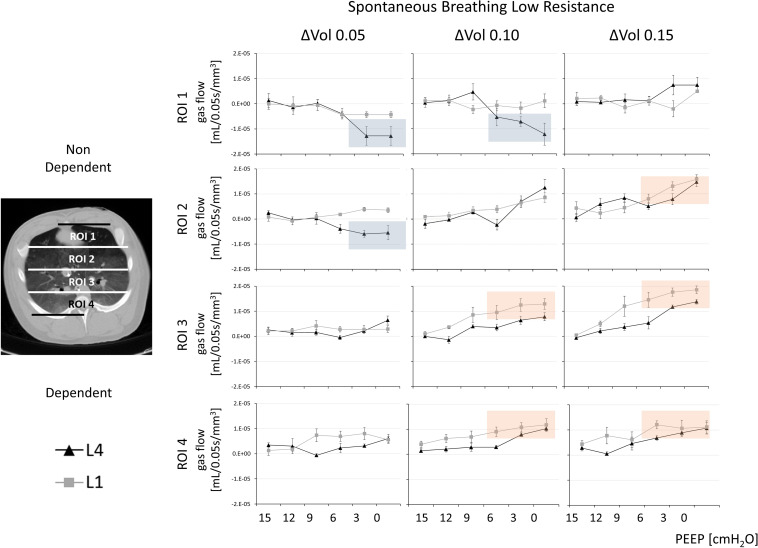
Gas redistribution during the isovolumetric phase of inspiration: the pendelluft analysis. Pendelluft during spontaneous breathing and low external airway resistance. Based on the estimated time to the onset of the inspiratory flow at the beginning of the inspiration, three delta volumes at, respectively, 0.05, 0.10, and 0.15 s (ΔVOL0.05, ΔVOL0.10, and ΔVOL0.15) were analyzed. Each delta-volume image was divided into four regions of interest (ROIs) along the gravitational axis (ROI1, ROI2, ROI3, and ROI4). The total amount of gas flow normalized for the corresponding ROI volume (ml/mm3; mean ± SE) (y-axis) was calculated at six different positive end-expiratory pressure (PEEP) levels (x-axis). The gray line indicates L1: 1 cm from the diaphragmatic dome. The black line indicates L4: 4 cm from the diaphragmatic dome. Complementary information in Figure 3 and Supplementary Figure 1.